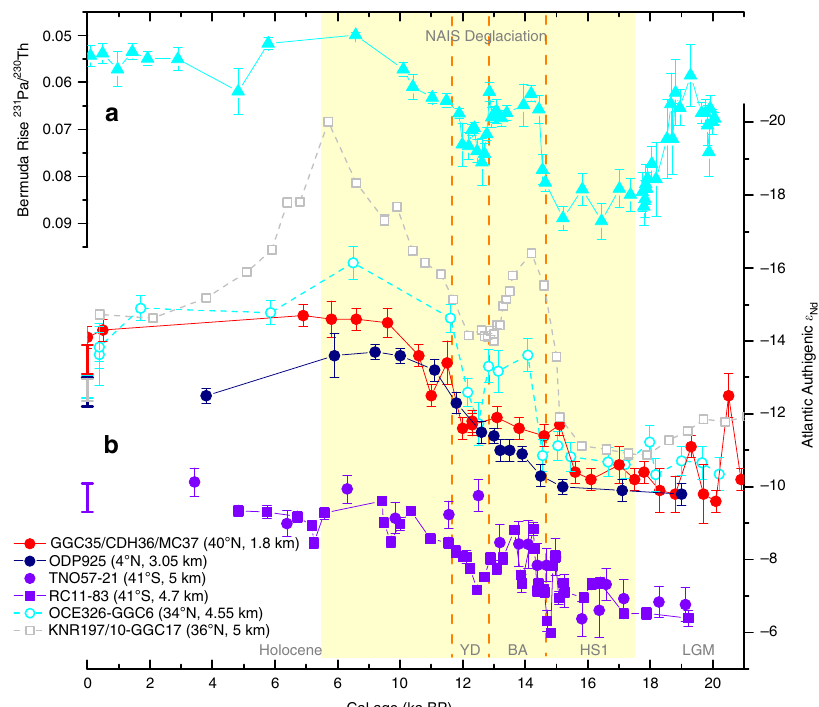
Fig. 3 Atlantic authigenic ε Nd records since the LGM. a 231 Pa/ 230 Th of OCE326-GGC5 from the Bermuda Rise 32 . b Authigenic ε Nd records from the mid- depth (this study) and deep North Atlantic 2,49 , and the deep equatorial 31 and South 4,73 Atlantic. Core locations are plotted on a meridional transect of Atlantic salinity today in Supplementary Fig. 8. Foraminiferal and fi sh teeth data are shown by dots, while the squares represent data based on sediment leachates. Records that are probably in fl uenced by a bottom source of unradiogenic Nd from poorly chemically weathered detritus 31 are shown by open symbols connected with dashed lines. Seawater data from the water samples closest to each core are shown with bars at 0 ka BP (see Supplementary Data 1 for details). All error bars are 2 σ . YD: Younger Dryas; BA: Bølling – Allerød; HS1: Heinrich Stadial 1; LGM: Last Glacial